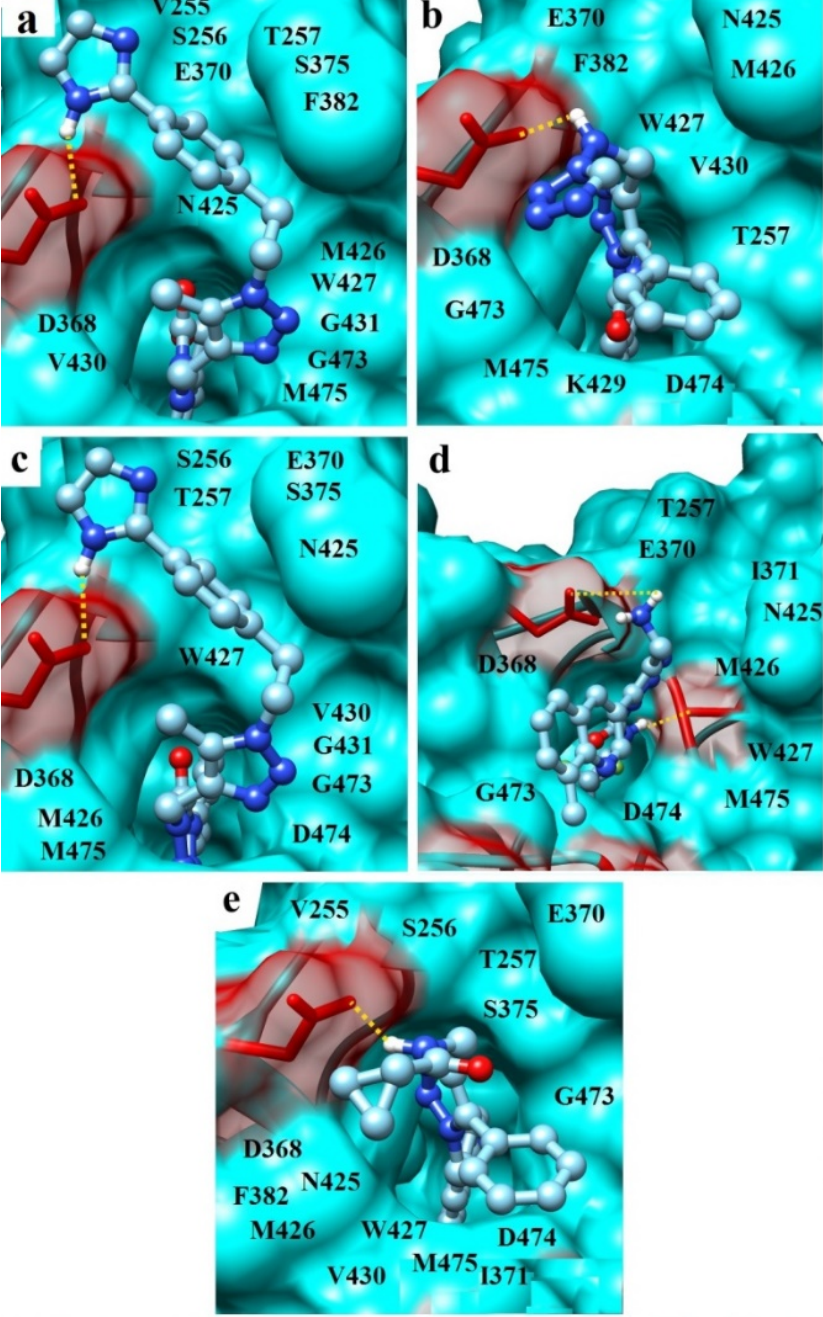
Figure 5. The PM7-based complexes of compounds I ( a ), II ( b ), III ( c ), IV ( d ) and V ( e ) with gp120. The Phe-43 cavity of gp120 and the residues located within the vestibule of this hydrophobic pocket are shown. The residues of gp120 forming hydrogen bonds and van der Waals contacts with the CD4- mimetic candidates are indicated (see Table 2, Figure 6). Hydrogen bonds are marked by dotted lines.